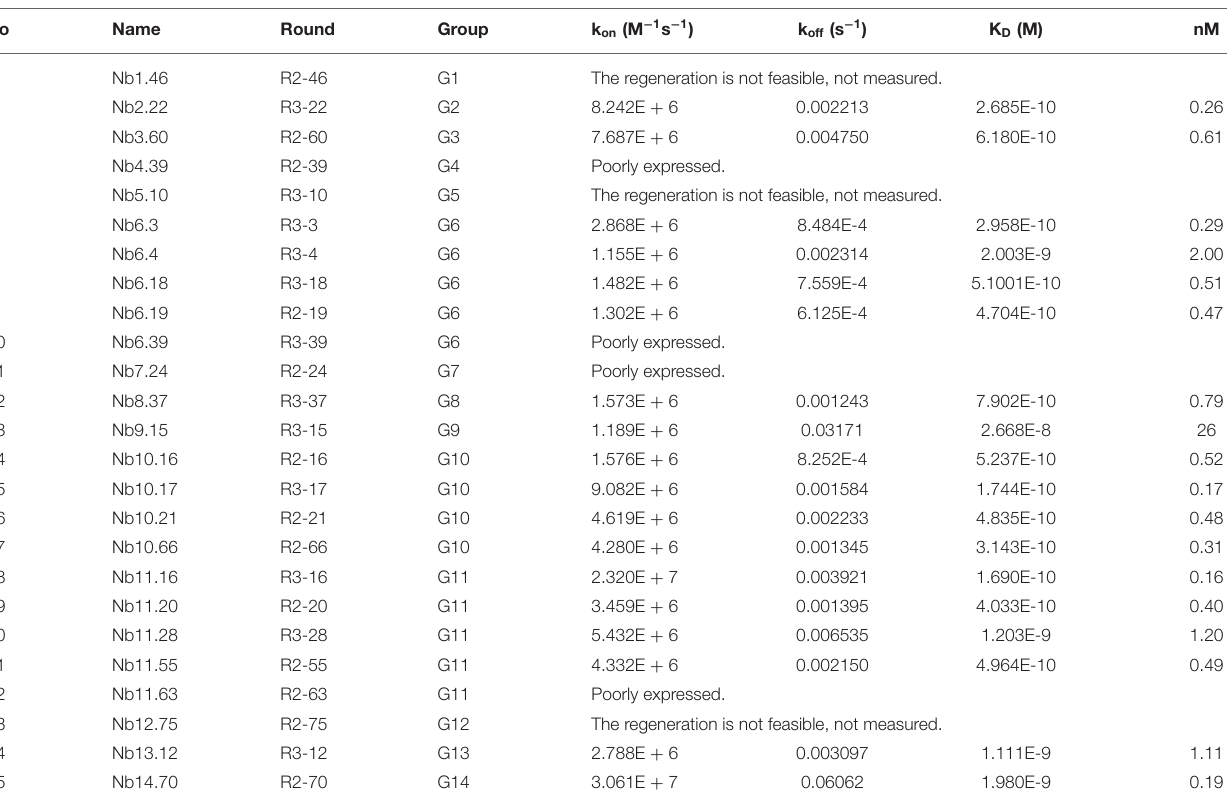
TABLE 2 | Kinetic rate and equilibrium binding constants of the Clec4F nanobodies, measured using surface plasmon resonance on immobilized recombinant mouse Clec4F